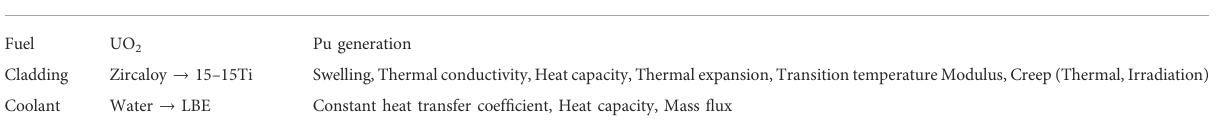
TABLE 4 Modi fi ed material and material properties in LFR fuel performance code.